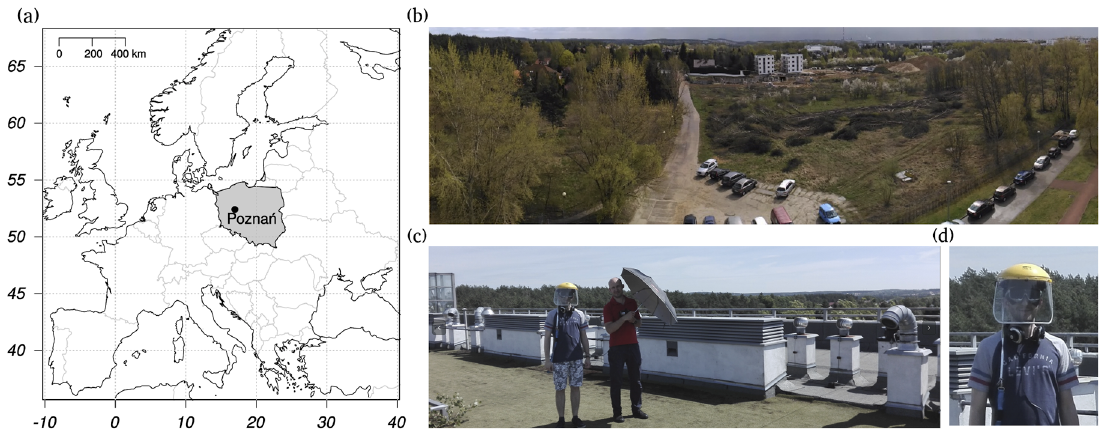
Figure 1. Research area: ( a ) location of Pozna ń ; ( b ) test landscape; ( c ) and ( d ) photographs taken at the observation point during eye tracker measurements.